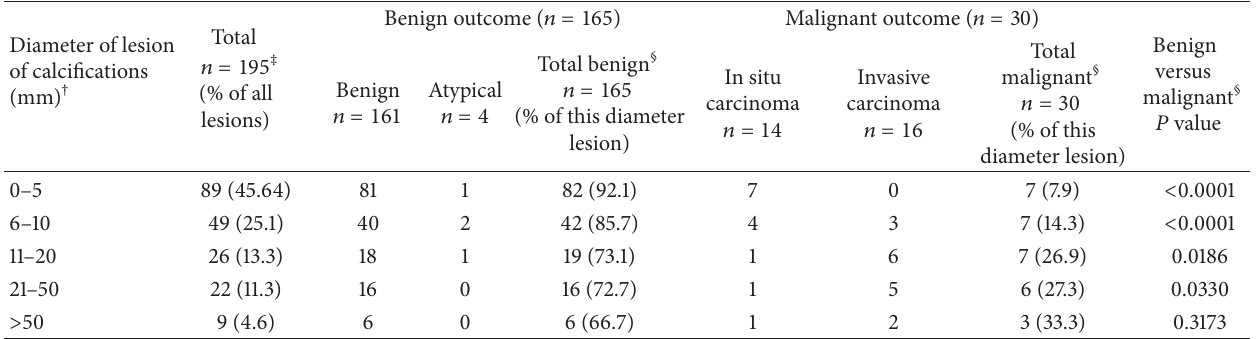
Table 4: Distribution of the diameter of the mammographic lesion of calcifications and final outcome ∗ . Diameter of